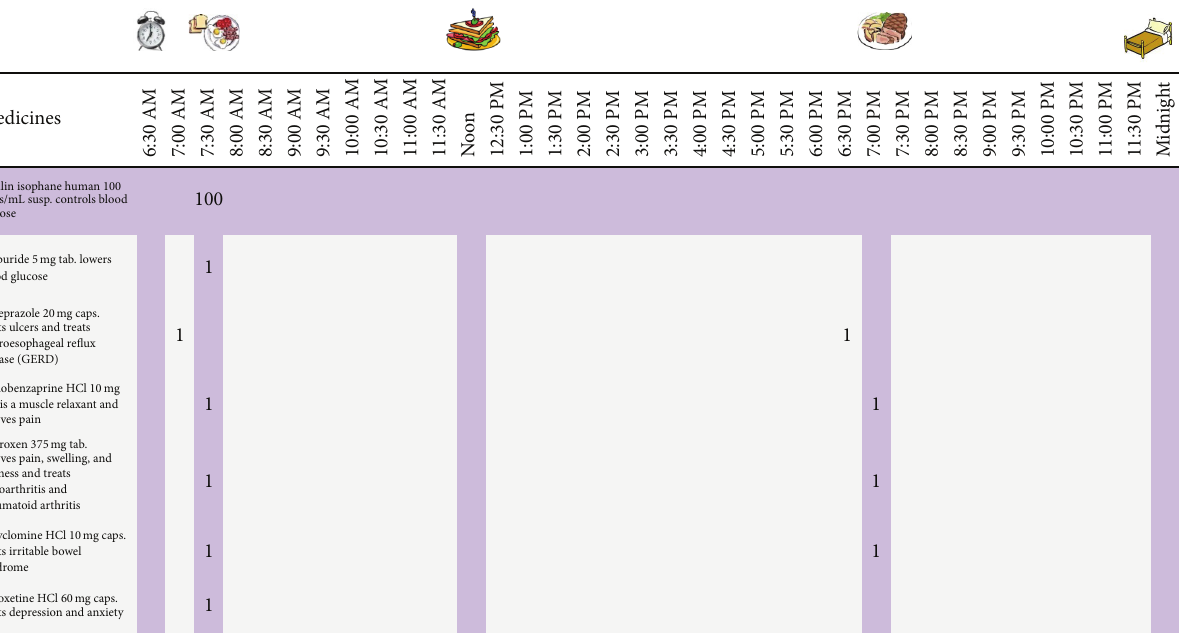
Figure 1: Example of Medtable. The patient and provider collaborate to choose times for each medication in the regimen. Modified and reprinted from [27] with permission from